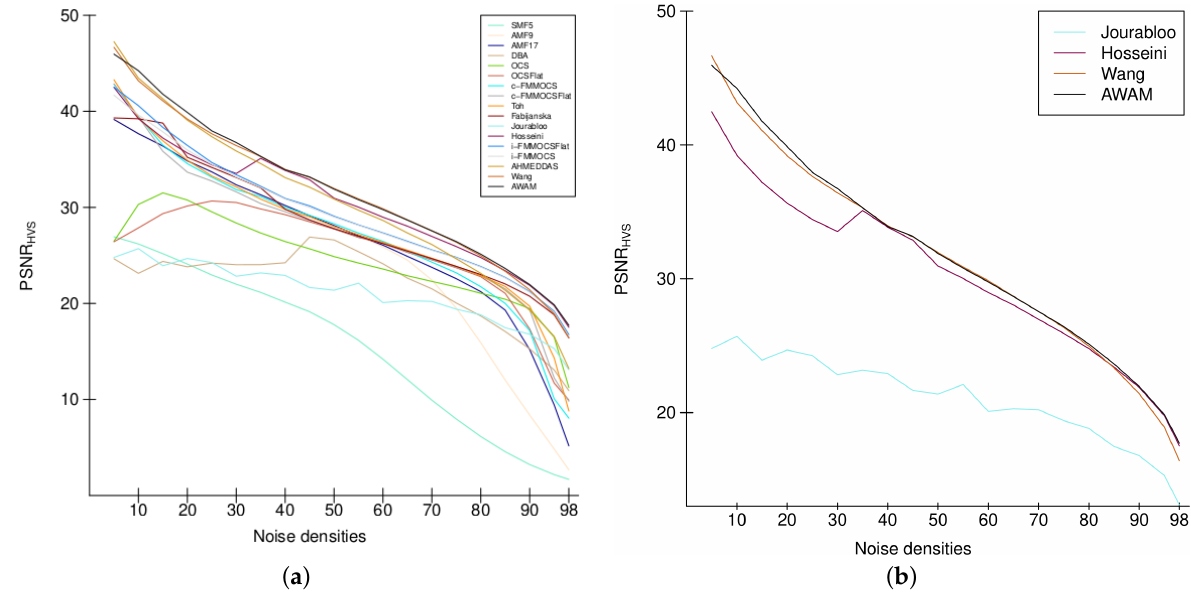
Figure 5. Graphical evolution of the means of the PSNR HVS values obtained by all the filters in the test set versus noise density. ( a ) Complete figure. ( b ) Figure including only those filters that obtain the best results in general according to Table 2.